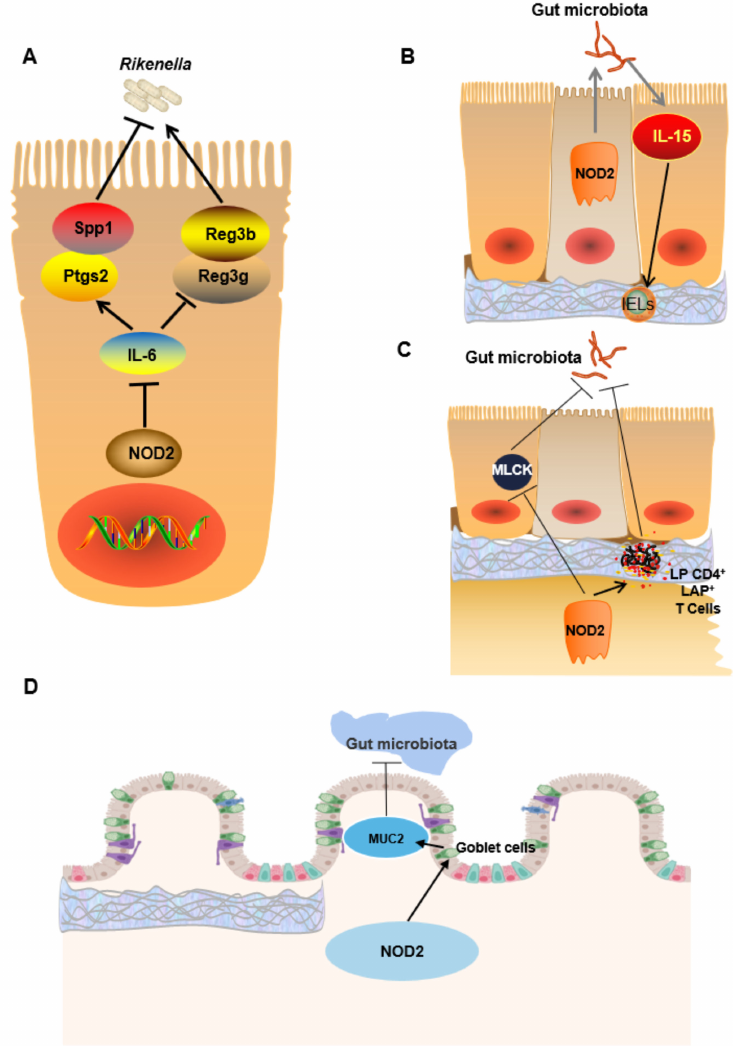
Figure 1. Nod2 mediated regulation of gut microbiota. ( A ) Nod2 in epithelial cells inhibits the expression of IL-6 and subsequently Ptgs2 and Spp1, and increases the expression of Reg3 β and Reg3 γ , thus increasing the abundance of Rikenella . ( B ) Nod2 maintains IELs via recognition of gut microbiota. The loss of IELs in Nod2 − / − mice is caused by the impaired expression of IL-15. ( C ) Nod2 can inhibit the overexpression of MLCK, avoiding the opening of tight junctions of epithelial cells, decreasing permeability of intestinal epithelial mucosa and bacterial translocation. Nod2 can also affect the number of LP CD4 + LAP + T cells, and regulate gut microbiota and improve colitis. ( D ) Nod2 can promote the secretion of Muc2 by intestinal goblet cells and enhances intestinal barrier function, thereby limiting bacterial